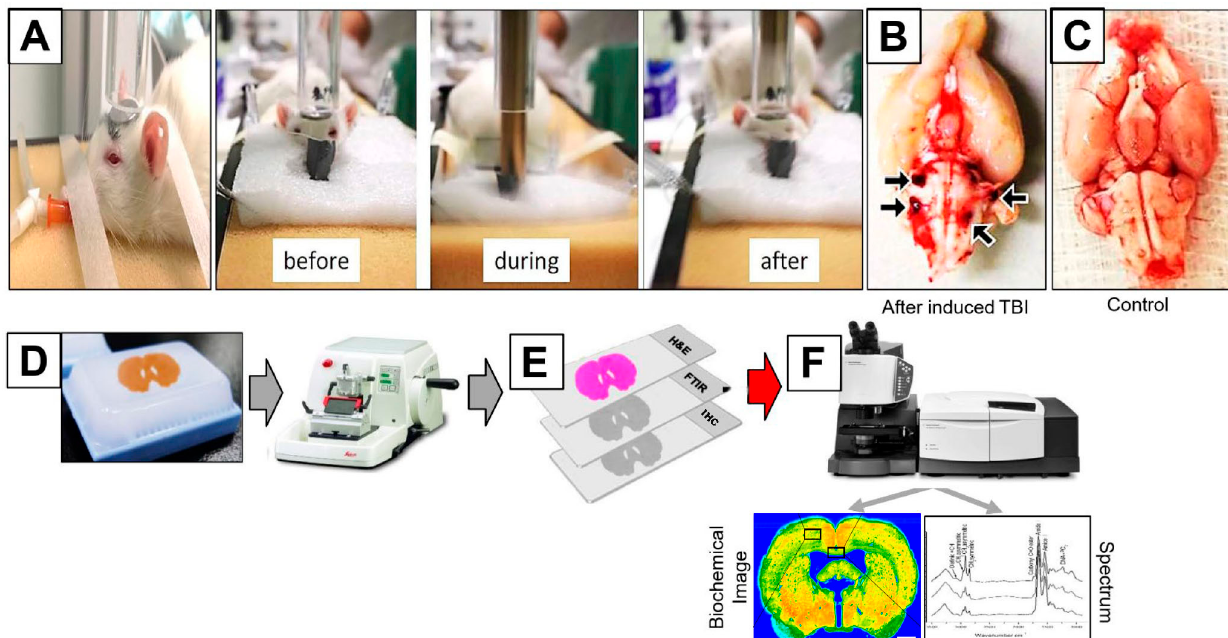
Figure 1. ( A ) Equipment and methods used to induce mTBI in rats. Displacement of an animal head as a result of the impact of a metal rod (weighing 450 g) dropped from a height of 1 m (the severity of TBI was controlled by changing the dropping height). ( B ) Brain showing hemorrhage in the stem and bleeding after mTBI. ( C ) Brain with no injury. Illustration of experimental workflow. ( D ) From the paraffin brain tissue block, 12 adjacent tissue sections of 10 µ m in thickness were cut using a microtome. ( E ) The first two sections were H&E stained while the consecutive 4 sections remained unstained. ( F ) IR spectra were recorded from different region of interest (ROI) on the unstained sections and spectral data were processed and biochemical images of the brain tissue are obtained. The following 6 sections were tested for histology and elemental analysis.